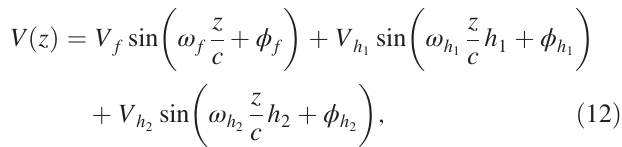
9. Bunch length distribution varies with the detuning frequency of the 2nd and 3rd harmonic cavity, disparate bunch lengthening circumstances correspond to different parts in the area, color bar presents the final bunch length from 1 cm to 6 cm. In which cool color area presents the near optimal lengthening condition, while the warm color area indicates that the bunch is